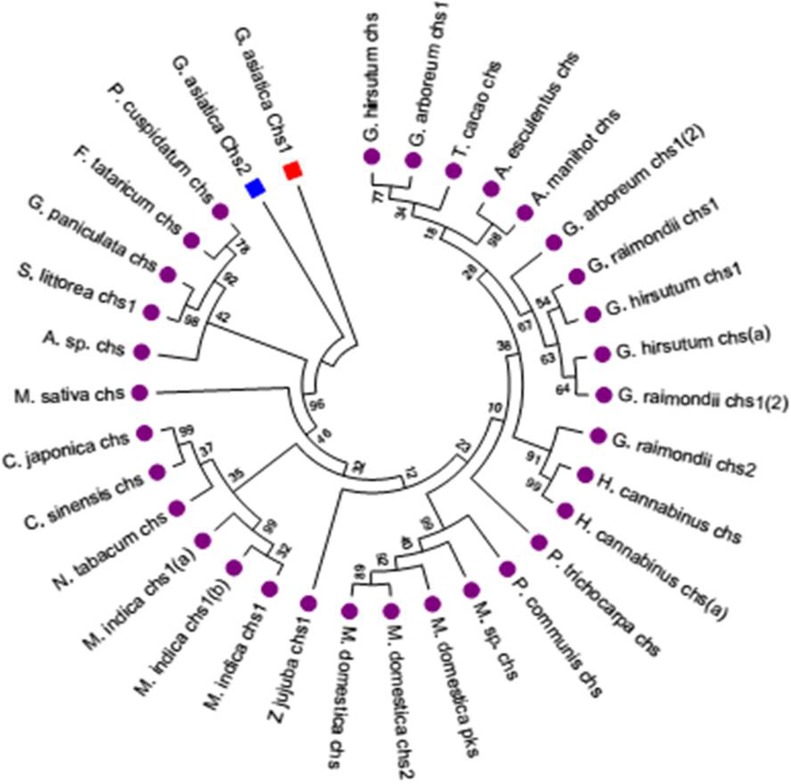
Phylogenetic analysis of GaCHS-1 and GaCHS-2.The phylogenetic analysis was performed based on Maximum Likelihood methodwith 1000 bootstrap replicates using the MUSCLE program and MEGA- 5 software. The analysis involved alignment of 34 amino acid sequences which were chosen by BLAST search of GaCHS genes from NCBI data-base. The desired sequences were selected based on the complete cds information available. The evolutionary distances were computed using the Poisson correction method. The database accession numbers of the CHS sequences used are as follows: GrewiaasiaticaCHS-1(KX129910), Grewia asiaticaCHS-2 (KX129911), Gossypiumhirsutum(AEO96985.1), Gossypiumarboreum CHS-1 (KHG25969.1), Gossypiumraimondii(XP_012454899.1), Theobroma cacao (EOY05368.1), Abelmoschusesculentus(AGW22222.1), Abelmoschusmanihot(ACE60221.1), Gossypiumhirsutum CHS2 (AEO96988.1), GossypiumraimondiiCHS1 (XP_012455000.1), Gossypiumarboreum(KHG14899.1), GossypiumhirsutumCHS1 (ACV72638.1), GossypiumraimondiiCHS2 (XP_012440802.1), Hibiscus cannabinusCHS1 (AIC75908.1), Hibiscus cannabinusCHS2 (AIA22214.1), MangiferaindicaCHS1 (AIY24986.1), MangiferaindicaCHS (AIB06736.1), MangiferaindicaCHS (AIY24987.1), Camellia sinensis(AGI02994.1), Camellia japonica (BAI66465.1), Ziziphus jujube (XP_015887549.1), Populustrichocarpa(EEE78799.1), Pyruscommunis (AAX16494.1), Malus hybridcultivar(ACN25139.1), Malus domesticaCHS2 (AFX71920.1), Malus domesticaCHS1 (AGE84303.1), Malus domesticaPREDICTED:polyketidesynthase5-like (XP_008380608.1), Medicago sativa CHS(AAB41559.1), Silenelittorea CHS1 (AMQ23617.1), Nicotiana tabacum CHS (AAK49457.1), Gypsophila paniculataCHS(AAP74755.1), Polygonum cuspidatum CHS (AFD64563.1), FagopyrumtataricumCHS(ADG02377.1), ArabidopsisCHS(AAB35812.1). The bar indicates an evolutionary distance of 0.02%.